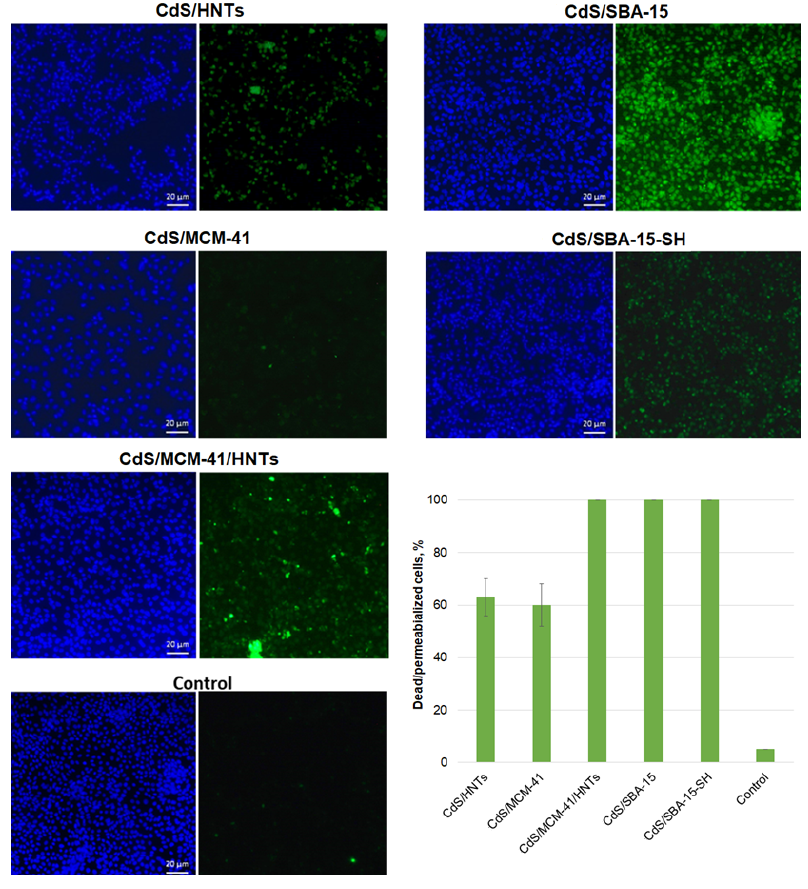
Figure 8. Dead or membrane-compromised cells’ nuclei stained as green, total cells’ nuclei counter- stained with DAPI.; Concentration of nanocomposites 100 μ g/mL; scale bar—20 μ m.